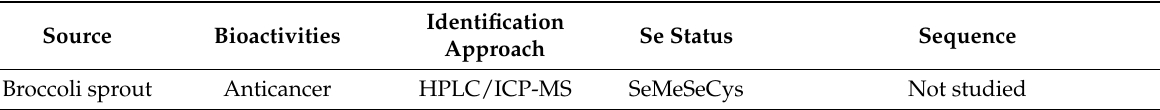
Table 4. The Biological activities of plant Se-enriched